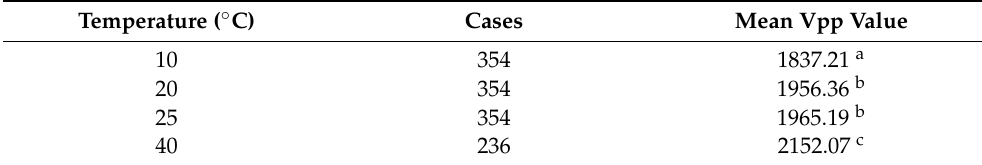
Table 4. Duncan’s Multiple Range Test for Temperature of Two-Way ANOVA results for Vpp with all gathered data.